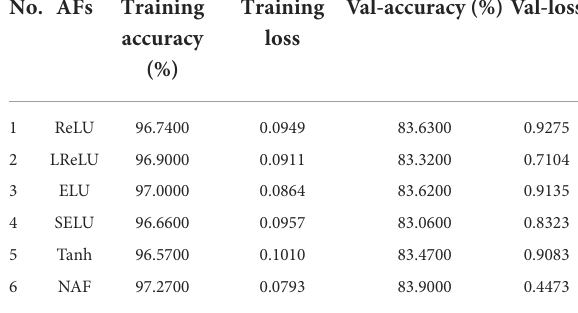
FIGURE6 GRU model. TABLE 2 Computer hardware and software.